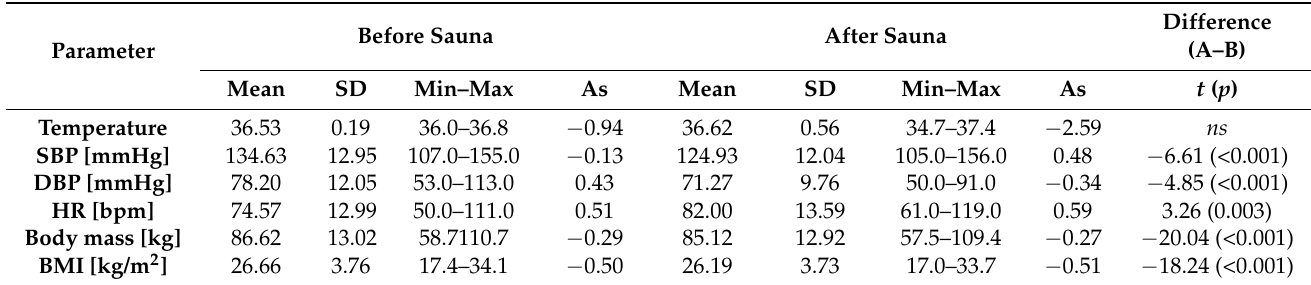
Table 2. Physiological parameters before and after sauna